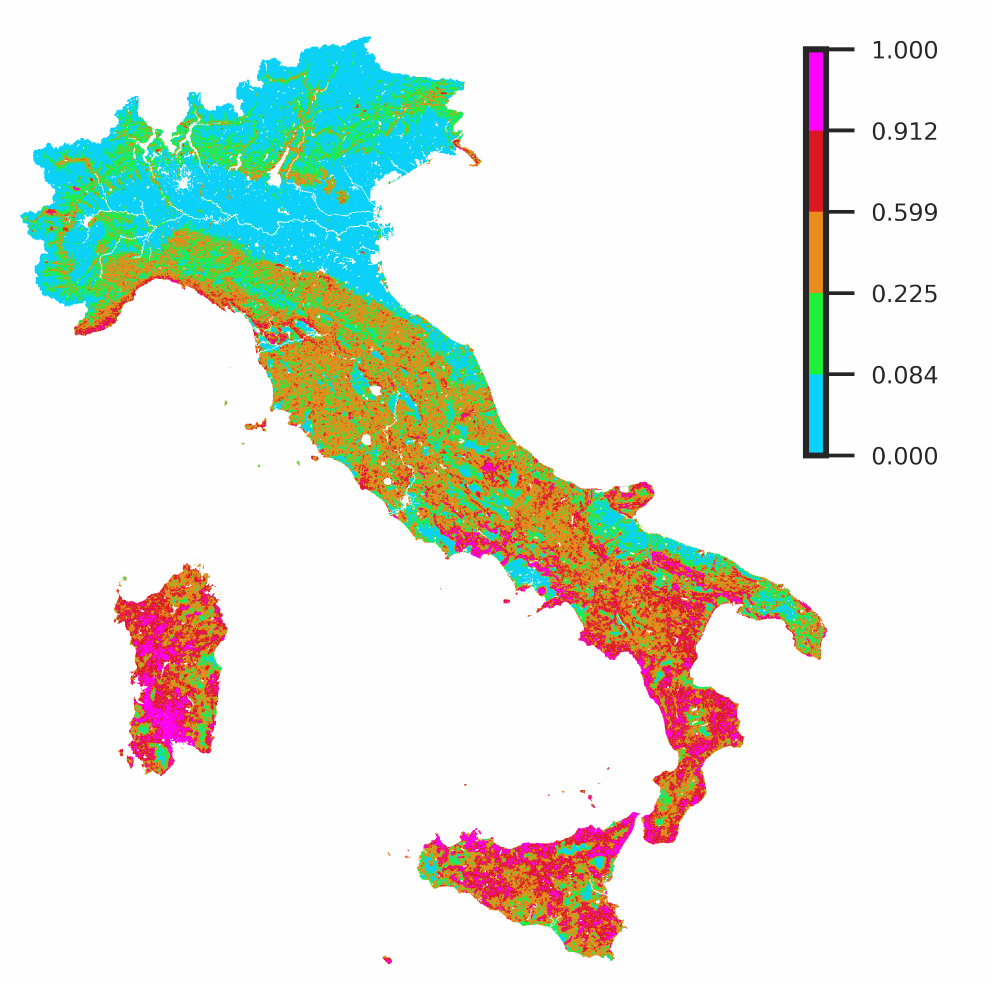
Figure 15. Susceptibility map for the summer fire season. To build the color palette, the continuous susceptibility values referred to the following percentiles have been calculated: 30–50–80–95. The color palette is therefore composed of five classes delimited by the susceptibility values of the following percentile class: blue (0–30), green (30–50), orange (50–80), red (80–95), purple (95–100). The computed numerical values are reported in the